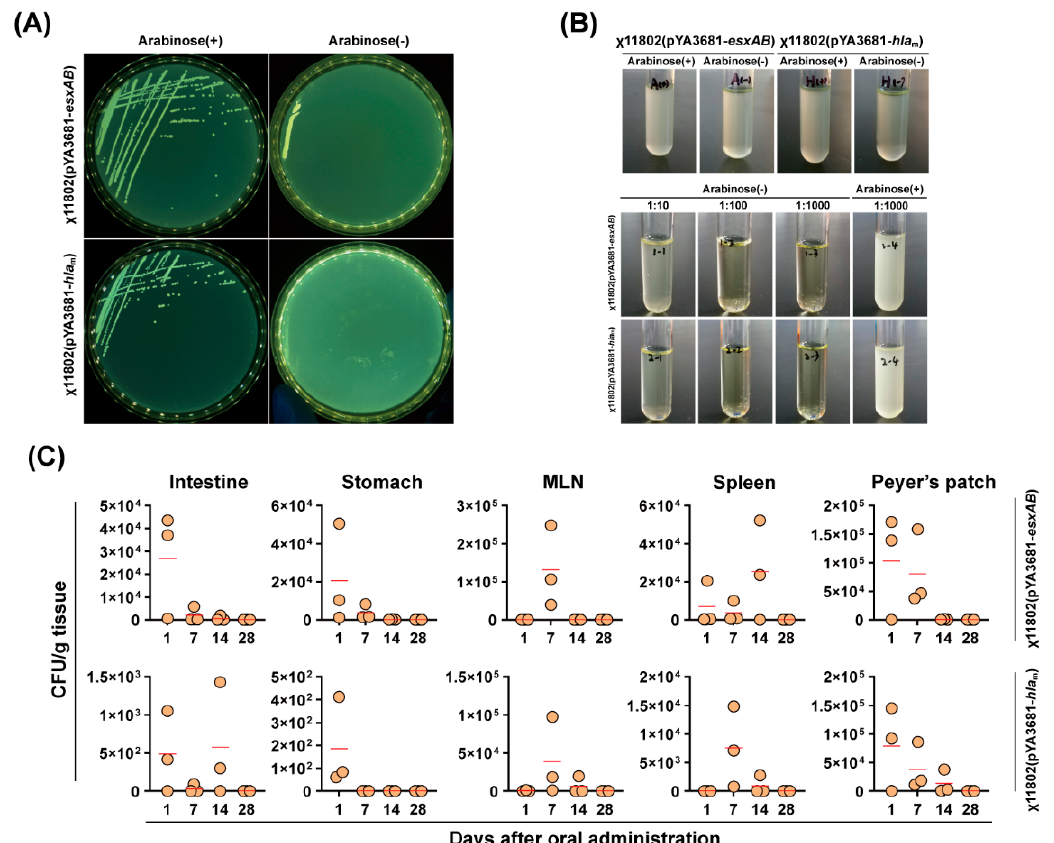
Figure 2. Recombinant strains of χ 11802 survival status in vitro and in vivo in the absence of arabi- nose. ( A ) χ 11802(pYA3681 − esxAB ) and χ 11802(pYA3681 − hla m ) survival status on LB plate with or without 0.02% w/v arabinose. ( B ) χ 11802(pYA3681 − esxAB ) and χ 11802(pYA3681 − hla m ) survival sta- tus in LB broth with or without 0.02% w/v arabinose. ( C ) Bacterial loading of χ 11802(pYA3681 − esxAB ) and χ 11802(pYA3681 − hla m ) in mouse intestines, stomachs, MLNs, spleens, and Peyer’s patches over time, after oral administration, with the Mean value of the bacterial loading presented as red